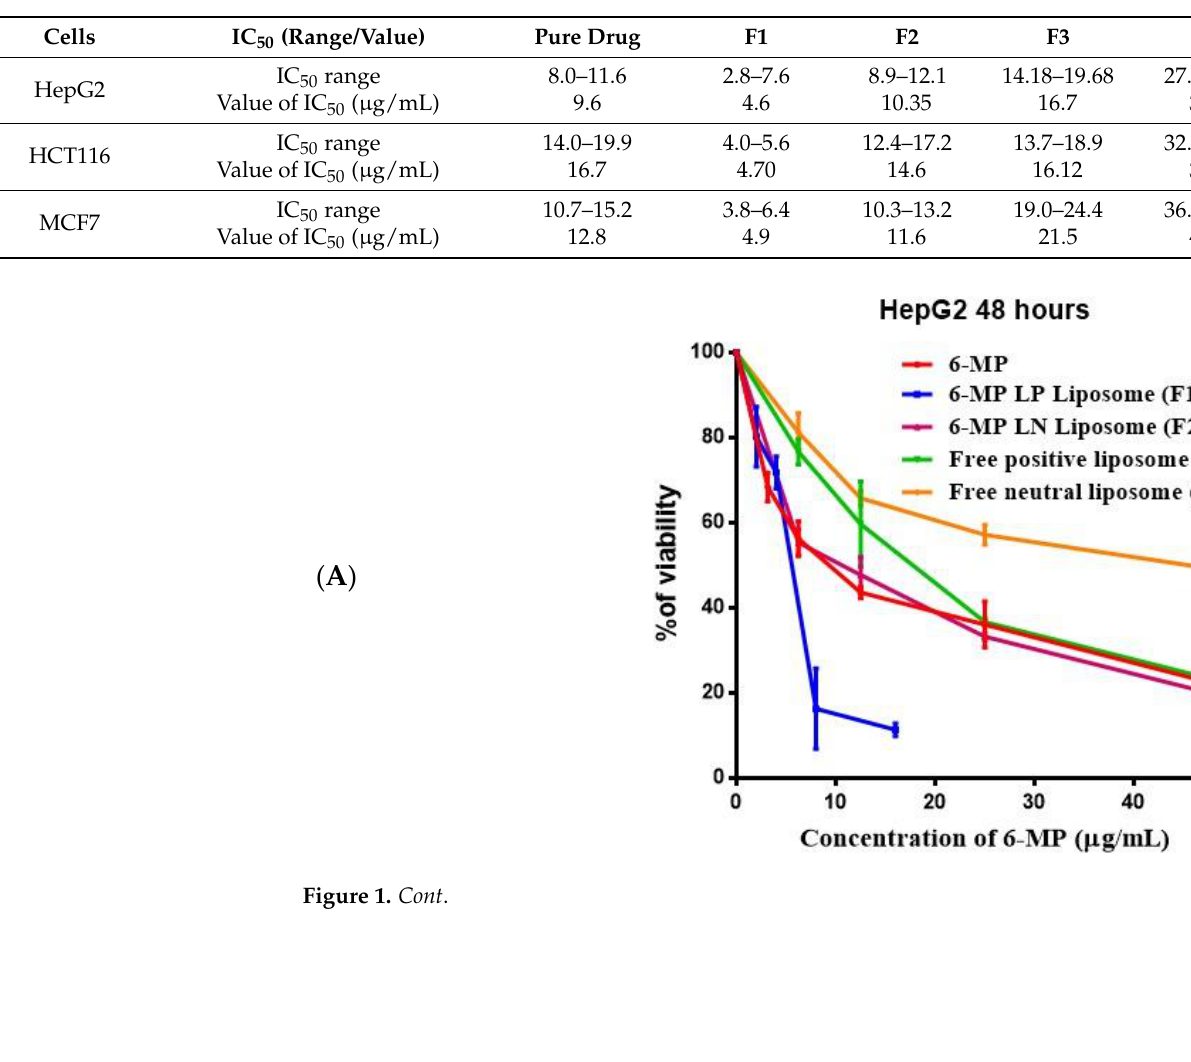
Table 2. IC 50 of the prepared liposomal formulations on HepG2, HCT116, and MCF-7 human cell lines after 48 h.